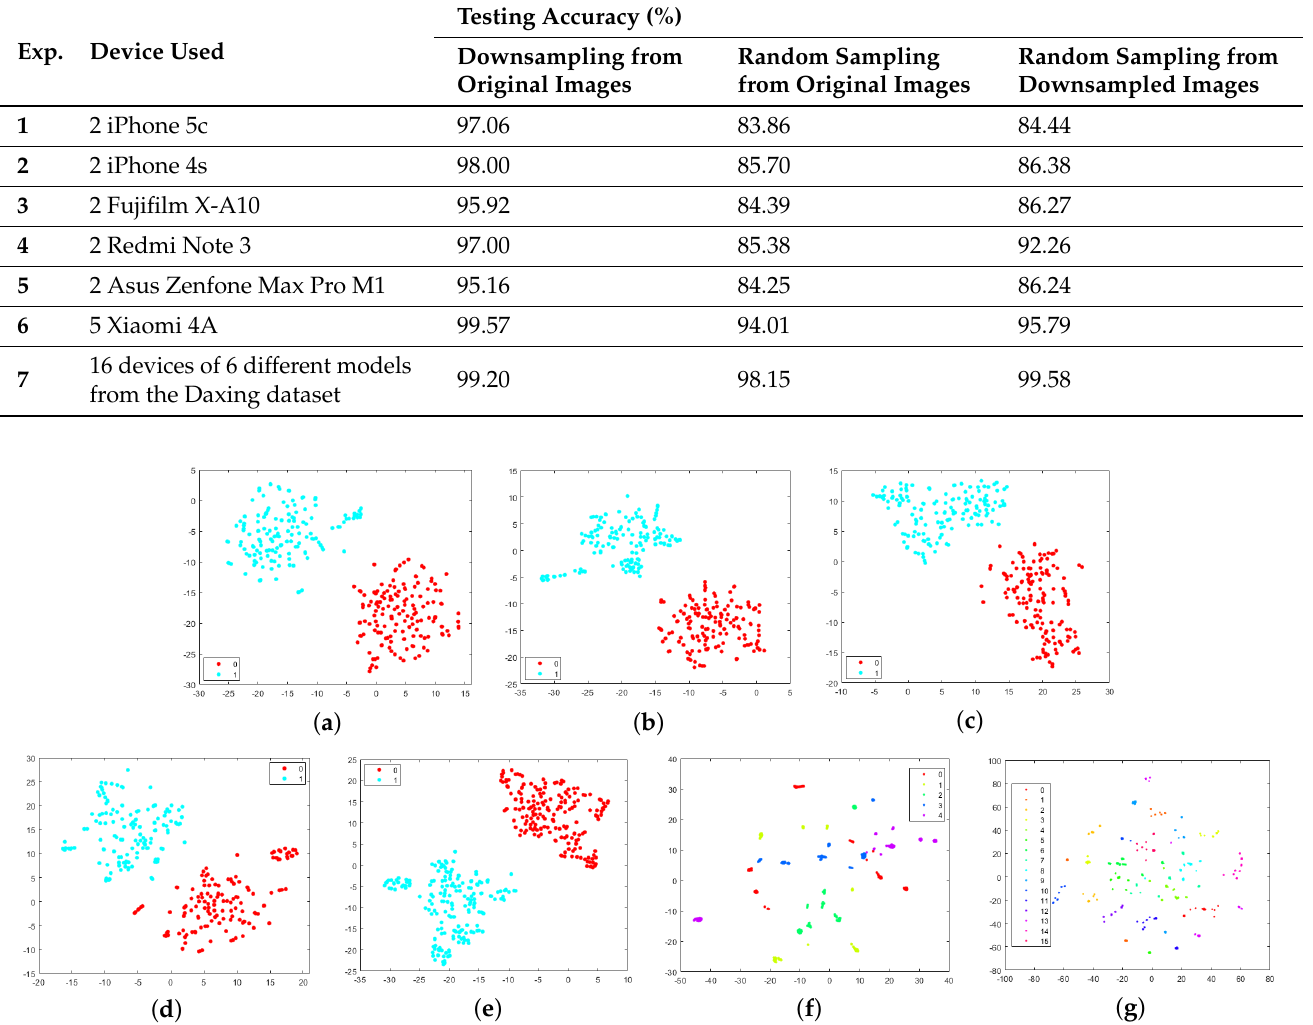
Table 3. Source-camera identification performance based on the non-PRNU fingerprint extracted from downsampled and randomly sampled images.